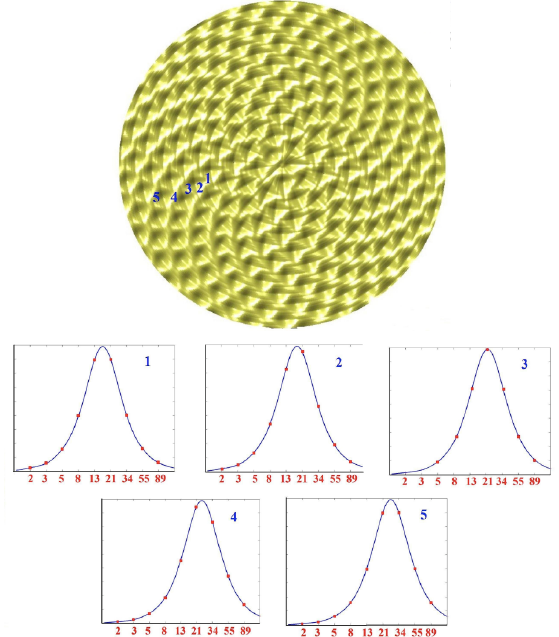
Fig. 6: Top: Graph of the function (5). Bottom: Graphs of ˆ A ( ρ = r/m j ) as a function of m j for various values of r , r = r 1 , r 2 = φ φ r 1 , r 4 = 3 φ r 1 , and r 5 = φr 1 2 4